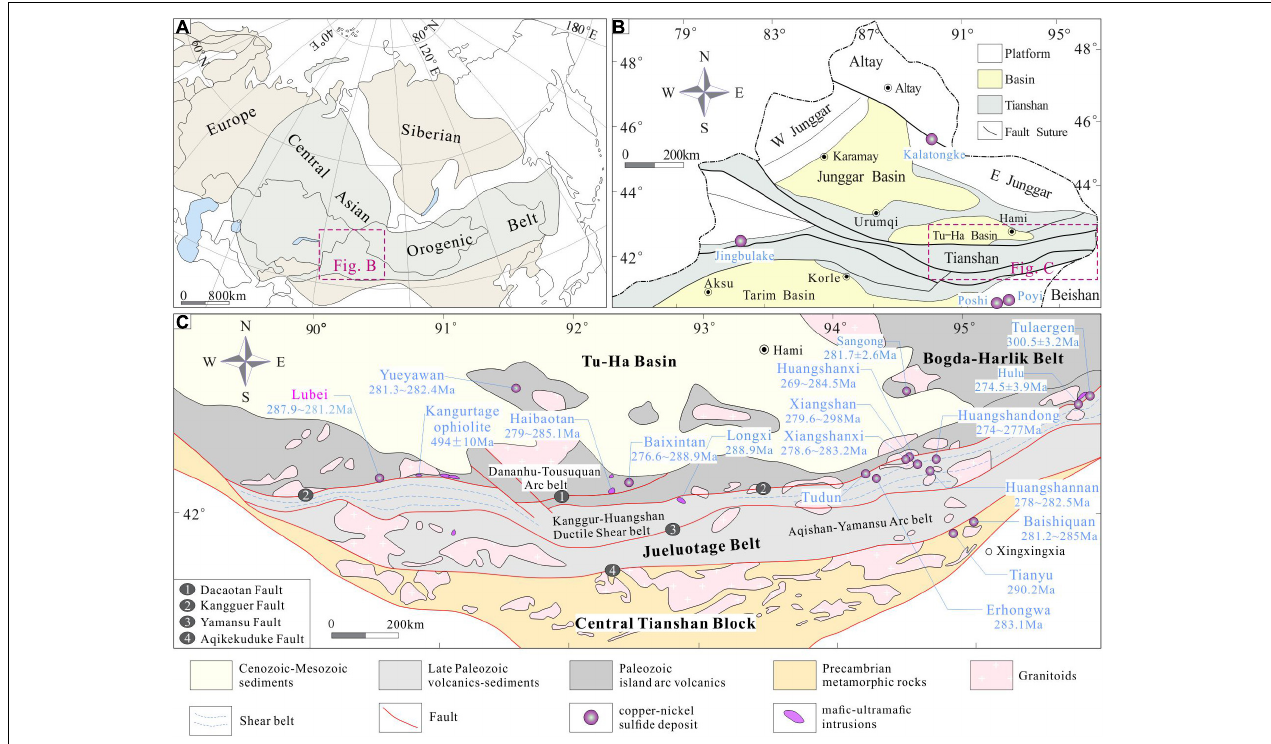
FIGURE 1 | (A) Simplified map of the CAOB; (B) Tectonic framework and representative Ni–Cu sulfide ore deposits in northern Xinjiang; (C) Simplified geological map of the eastern Tianshan showing the distribution of early Permian mafic–ultramafic intrusions. See Supplementary Appendix 1 for details on